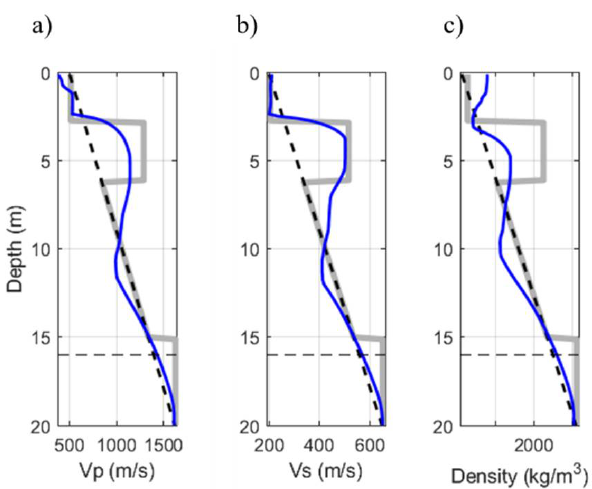
Figure 9. Model fitting when using a high-frequency source signal: ( a ) vertical profiles of the P- wave velocity model, ( b ) vertical profiles of the S- wave velocity model, ( c ) vertical profiles of the density model. The true model is plotted with the grey line, the initial model is represented by the dashed black line and vertical profile at x = 25 m of the inverted models is the plotted blue line.